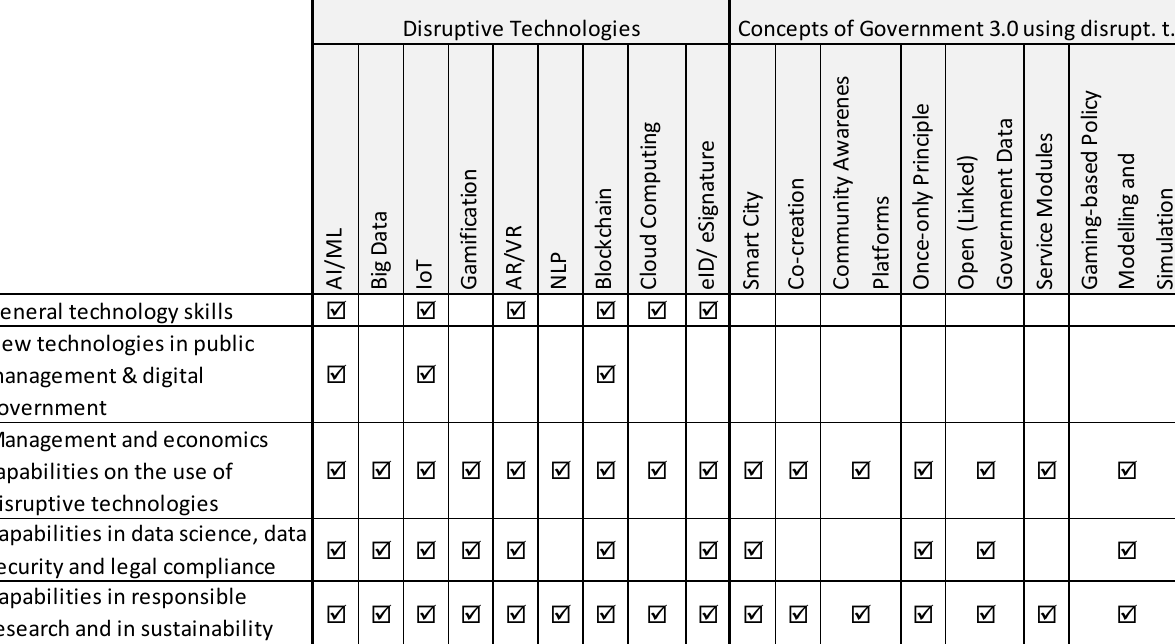
Table 3: Correspondence of training needs along with disruptive technology use in public